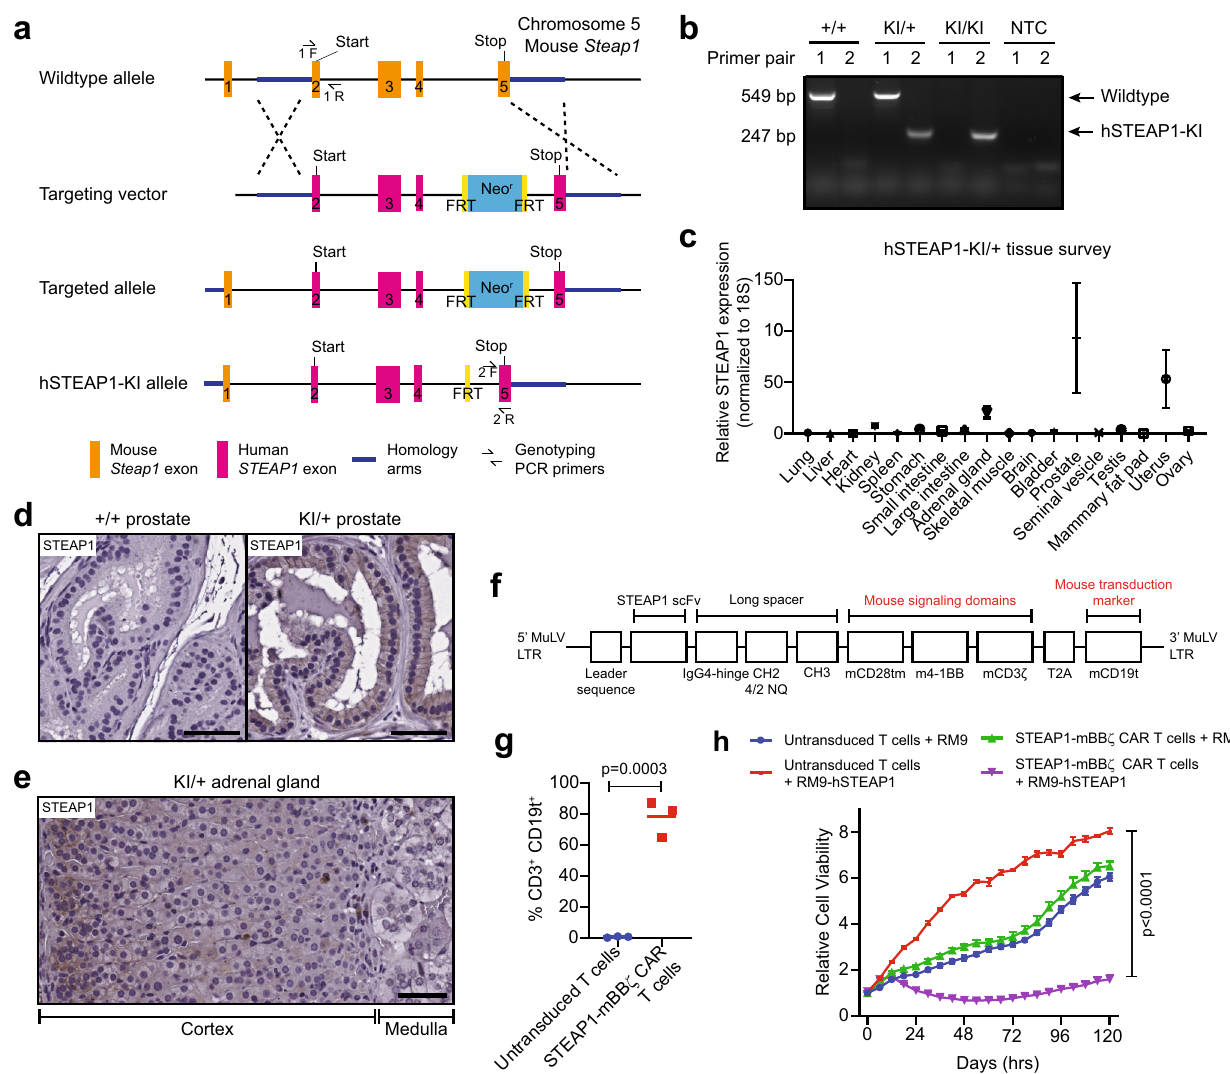
Fig. 4 | Establishing a mouse-in-mouse system with a human STEAP1 knock-in (hSTEAP1-KI) mouse model and murinized STEAP1 CAR. a Schematic showing the homologous recombination strategy using a targeting vector to knock-in human STEAP1 exons 2 – 5 into the mouse Steap1 locus on the C57Bl/6background. FRT Flippase recognition target. b Visualization of PCR products from tail tip genotyping of wildtype (+/+), heterozygous (KI/+), or homozygous (KI/KI) mice using primer pairs intended to amplify portions of wildtype or hSTEAP1-KI alleles. NTC null template control. Representative gel image from n =3 biologically inde- pendent experiments. c qPCR for human STEAP1 expression normalized to 18S expression in a survey of tissues from hSTEAP1-KI/+ mice. n =3 for sex-speci fi c organs and n =6 for common organs. Bars represent mean with SEM. Photo- micrographs of STEAP1 IHC staining of ( d ) prostate tissues from (left) +/+ and (right)KI/+miceand( e )anadrenalglandfromaKI/+mouse.Scalebars=50 µ m.For